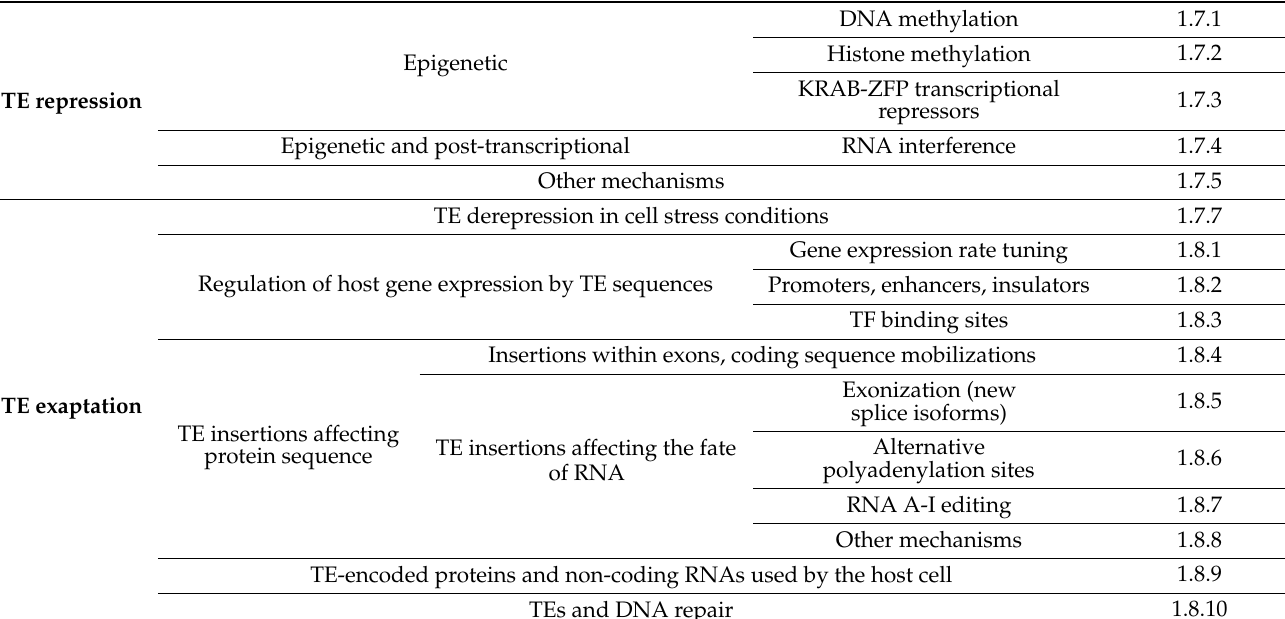
Table 1. Mechanisms of interaction between TEs and host organisms. The right column shows section numbers in the present